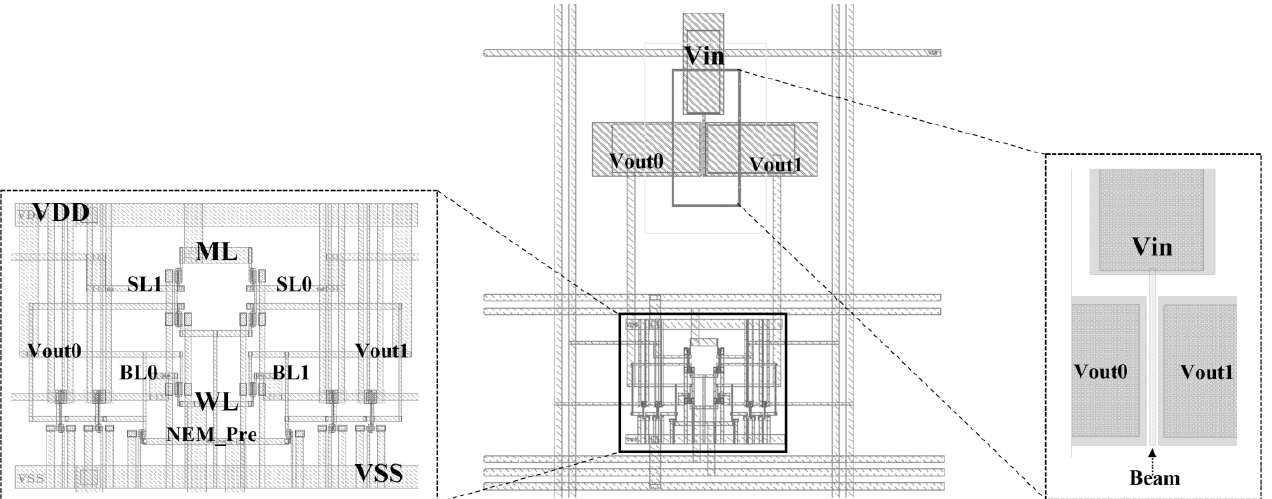
Figure 10. Layout design of NEM-based CAM cell and memory switch.